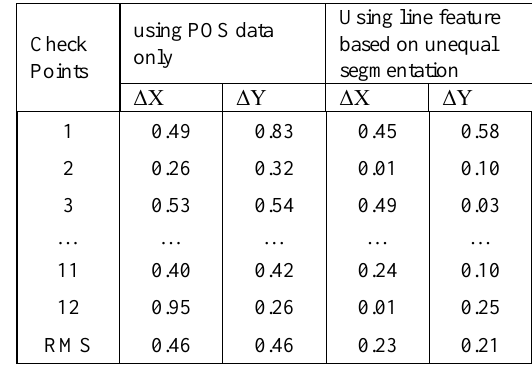
Figure 3. Geometric rectification result only using POS data